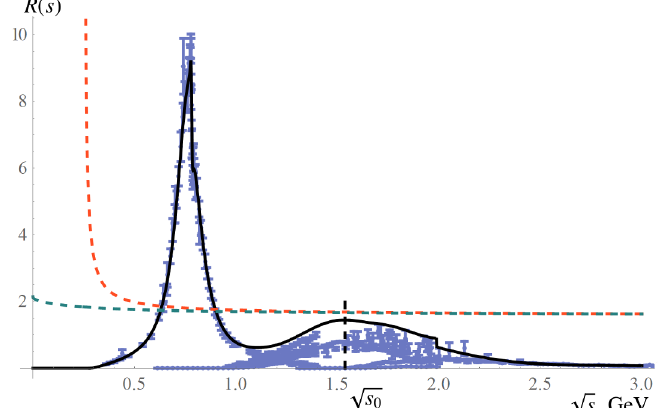
√ √ s at s ≤ 3 GeV (black), the experimental data